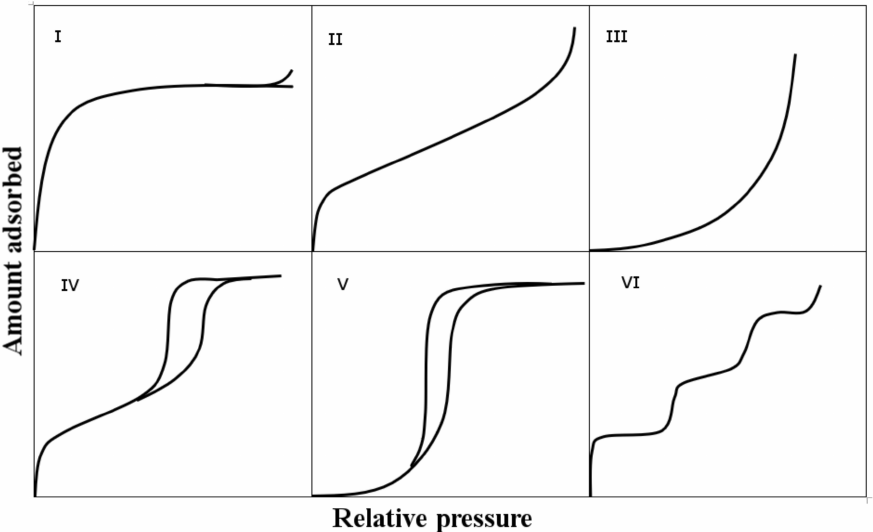
Figure 3. Amount of gas adsorbed as a function of the relative pressure at constant temperature: comparison between representative adsorption models: types I, II, III, IV, V and VI.